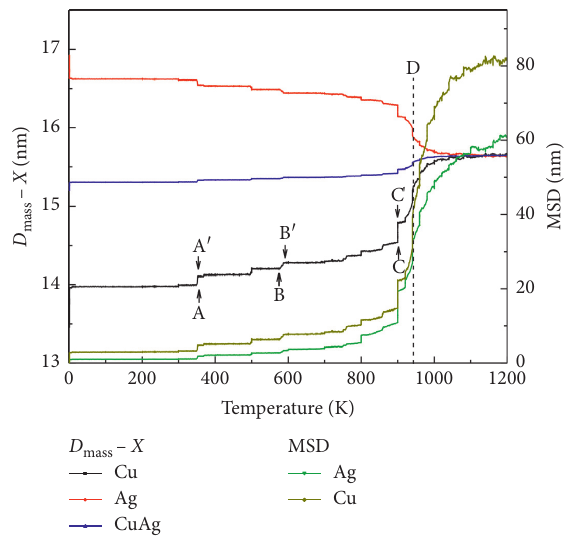
Figure 2: Temperature dependence of D 3